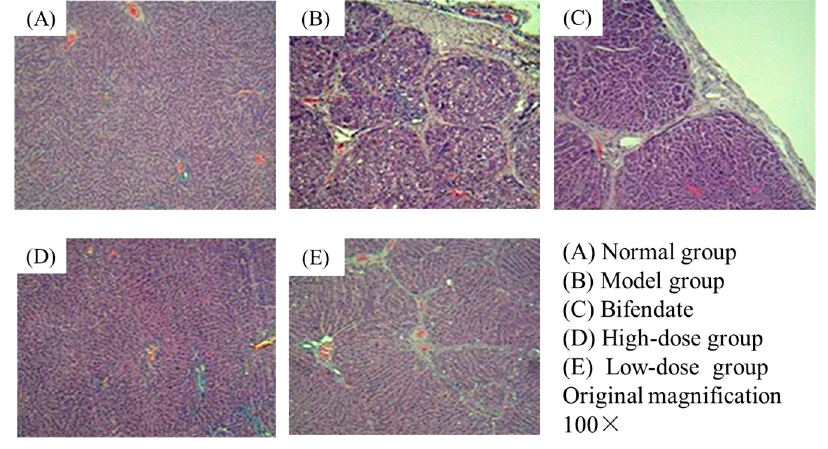
Figure 2. Histological examination of rat livers stained with hematoxylin-eosin (H&E). ( A ) Normal group, without any abnormal morphological alternations; ( B ) model group, showing marked morphological disruption; ( C ) bifendate (10.5 mg/kg), showing notable alleviation in abnormal areas; ( D ) high-dose group (Oxy-Di-OA, 28 mg/kg), showing marked regression and alleviation in the abnormal areas; and ( E ) low-dose group (Oxy-Di-OA, 14 mg/kg), showing moderate regression of morphological changes.